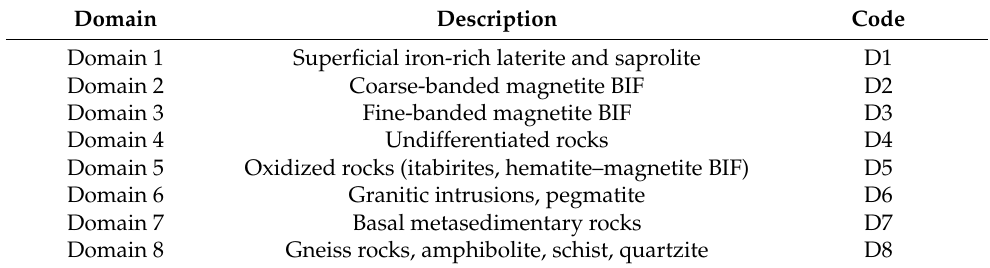
Table 1. Geological domain definition.